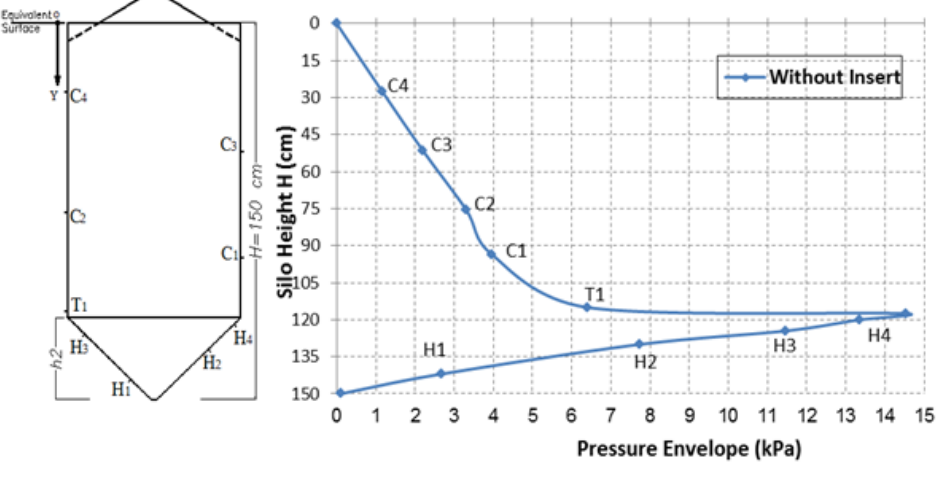
Figure 7 : Dynamic horizontal pressure distribution that resulted on the silo wall without insert (no insert used)